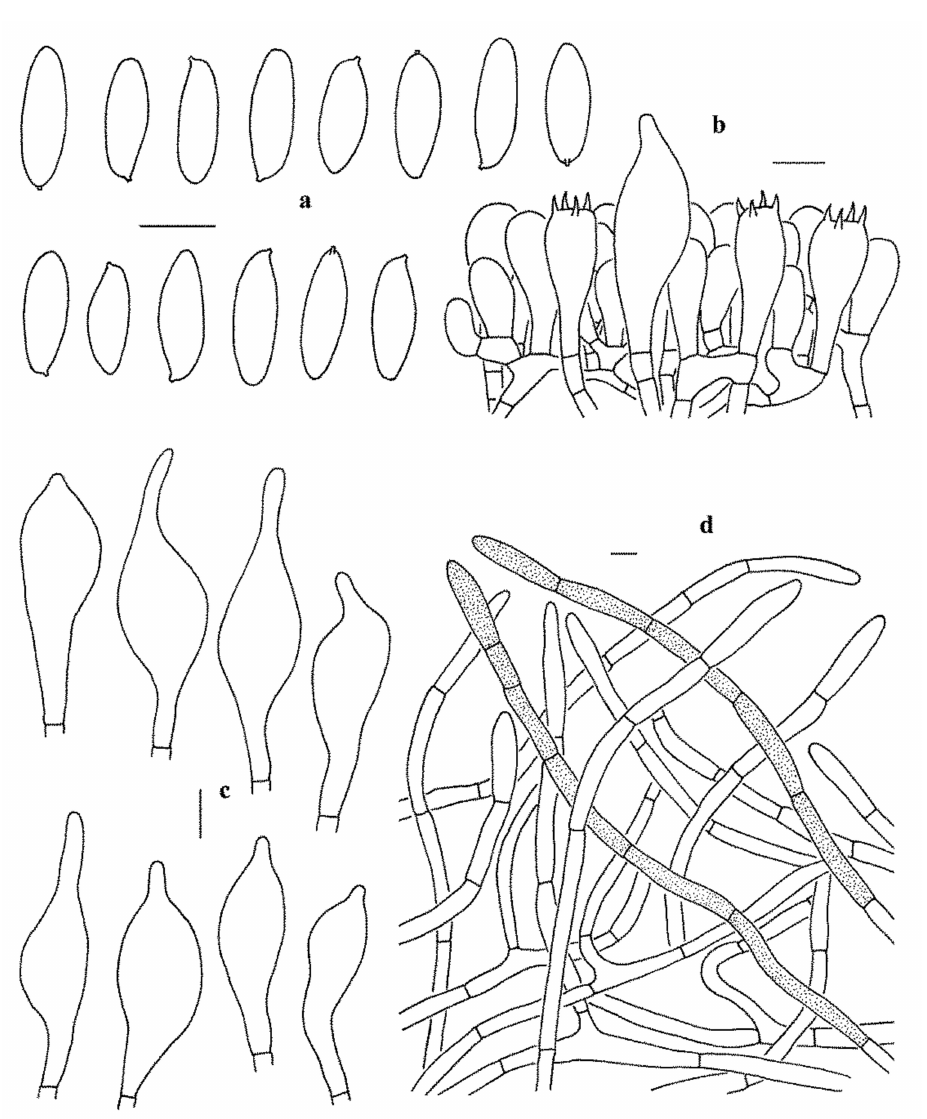
Figure 4. Microscopic features of Leccinum album (KUN-HKAS53417, holotype). ( a ) Basidiospores. ( b ) Basidia and pleurocystidium. ( c ) Cheilocystidia and pleurocystidia. ( d ) Pileipellis. Bars = 10 µ m. Drawings by Y.-C. Li. Basidiospores (40/2/1) 15–19 × 5–7 µ m, Q = 2.5–3, Q m = 2.75 ± 0.15,